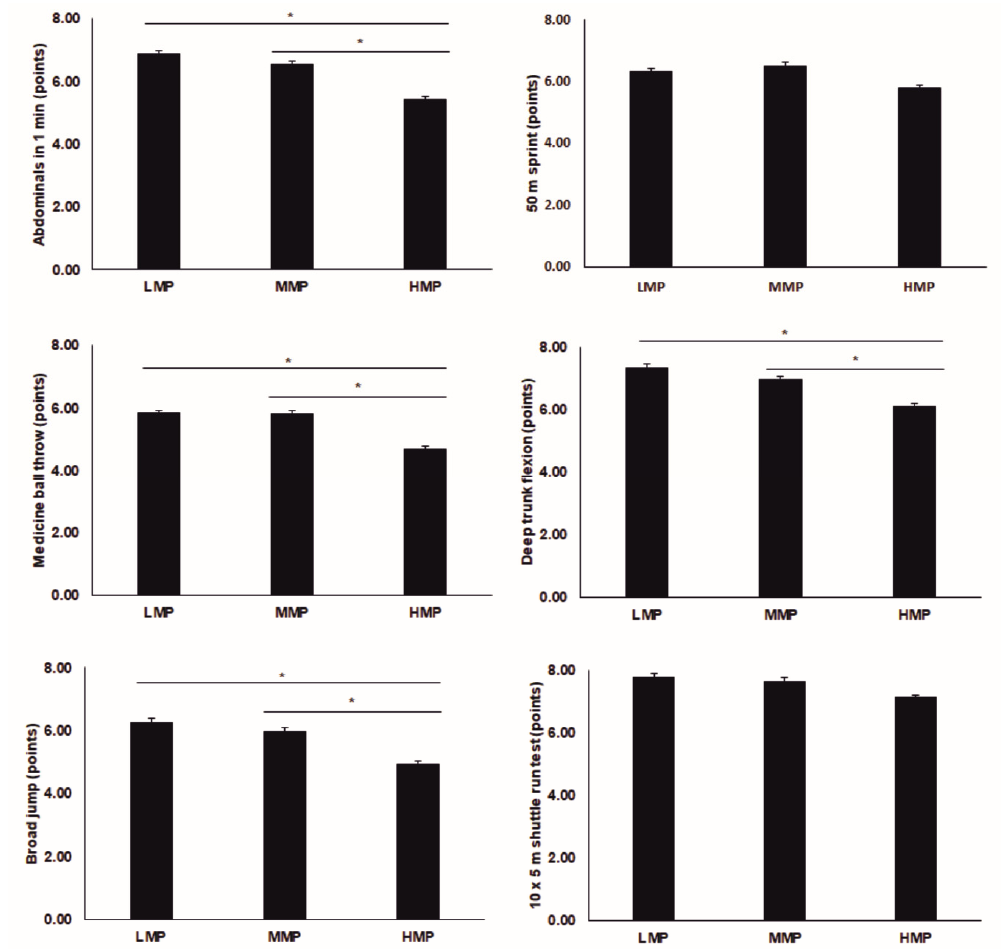
Figure 2. Results of physical fitness test. LMP = low use of the mobile phone; MMP = medium use of the mobile phone; HMP = high use of the mobile phone. * significant differences between groups; significant criteria p < 0.05. Within the boys’ group, intermobile phone-use differences were observed in the PF performance being higher in the values of LMP group than HMP group for the ab- dominals test ( p = 0.005), medicine-ball throw ( p = 0.047), broad jump ( p = 0.009) and trunk- flexion test ( p = 0.047). In addition, higher values were also described for MMP than HMP in the abdominal test ( p = 0.007), medicine-ball throw ( p = 0.009) and trunk-flexion test ( p